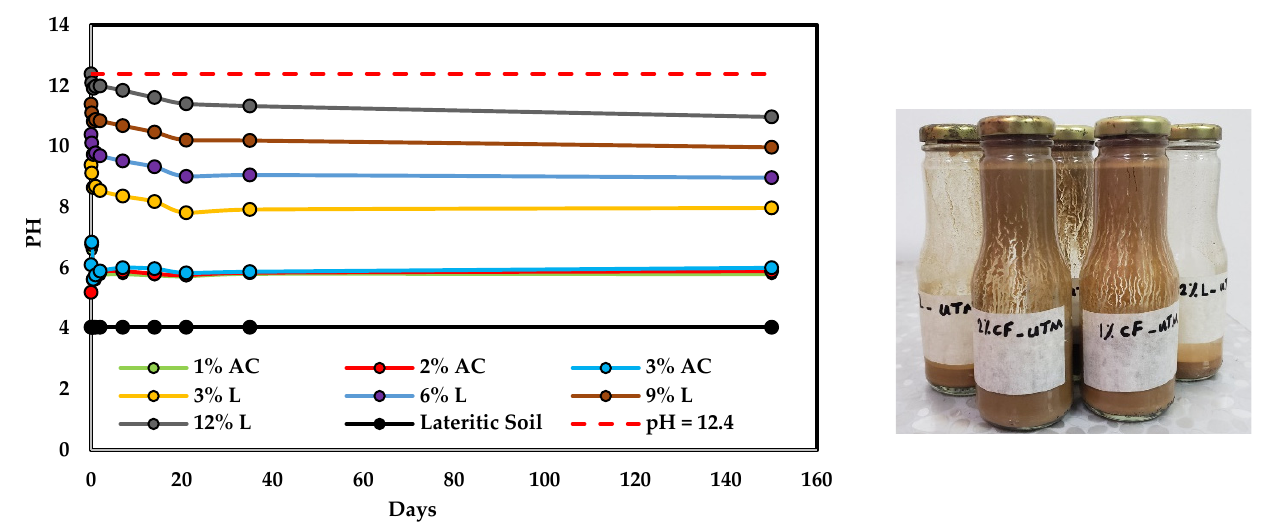
Figure 3. Variation in pH value after adding the various percentage of AC and lime.